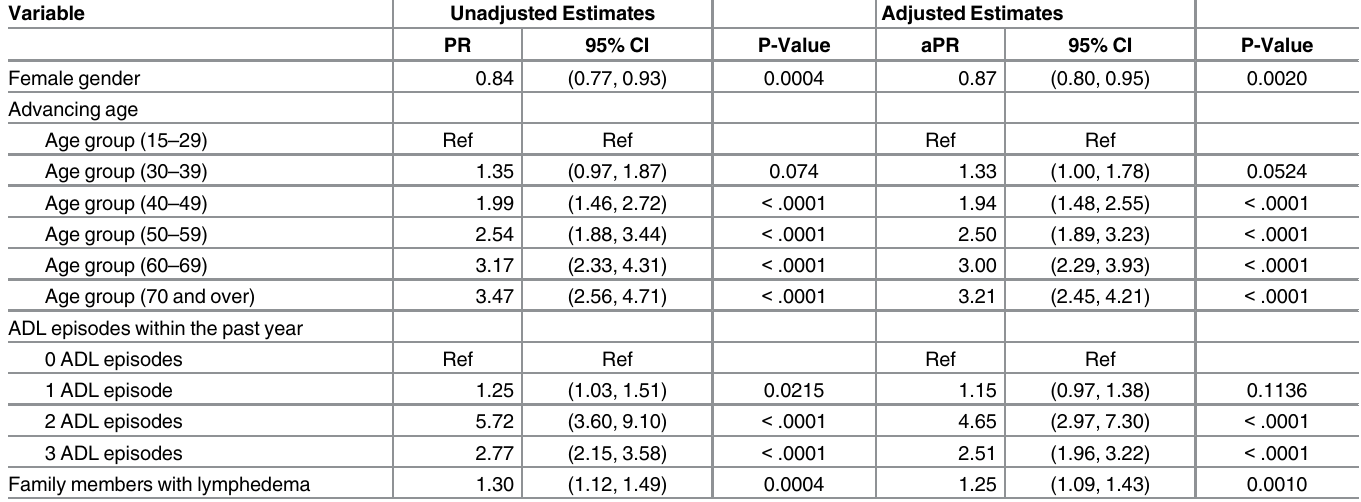
Table 2. Risk factors for advanced lymphedema (Stages 4 – 7) in surveyed individuals ages 15 – 99 in Khurda District, Odisha State, India (N =